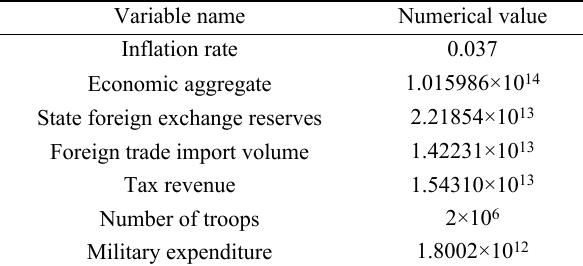
Table 2 Reference table of parameters in the